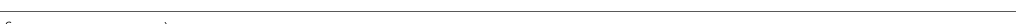
figure on next Fig. 1 Dex inhibited the differentiation of osteoblasts and reduced D1R expression in vitro. A CCK-8 analysis of Dex-induced MC3T3-E1 cells. B Representative images showing ALP staining. Scale bar: 200 μm. C Quantitative analysis of ALP staining. n significant, * p < 0.05, ** p < 0.01, vs. the Dex ( ) group. D Representative images showing ARS staining. Scale bar: 200 μm. E Quantitative analysis of − ARS staining. n 3 per group. NS: Not statistically significant, * p < 0.05, ** p < 0.01, vs. the Dex ( = probed with antibodies against the osteogenesis-specific proteins ALP, OSX, and Runx2 and the dopamine receptors D1–D5. G – N Quantification of the protein levels. n 3 per group. NS: Not statistically significant, * p < 0.05, ** p < 0.01, vs. the Dex ( =